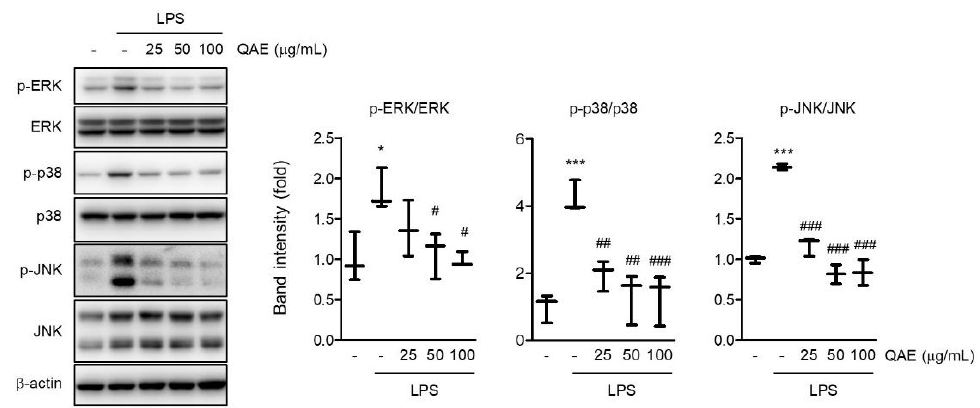
Figure 5. QAE inhibits the mitogen-activated protein kinase (MAPK) signaling pathway in LPS-stimulated BV2 microglial cells. After QAE pretreatment (25–100 µ g/mL) for 3 h, BV2 microglial cells were exposed to LPS (100 ng/mL) for 1 h. Expressions of phosphorylated extracellular signal-regulated kinase (ERK), p38, and c-Jun N-terminal kinase (JNK) were normalized by expression of ERK, p38, and JNK protein expression, respectively ( n = 3). Significant versus control, * p < 0.05, *** p < 0.001; Significant versus LPS alone-treated group, # p < 0.05, ## p < 0.01, ### p < 0.001.